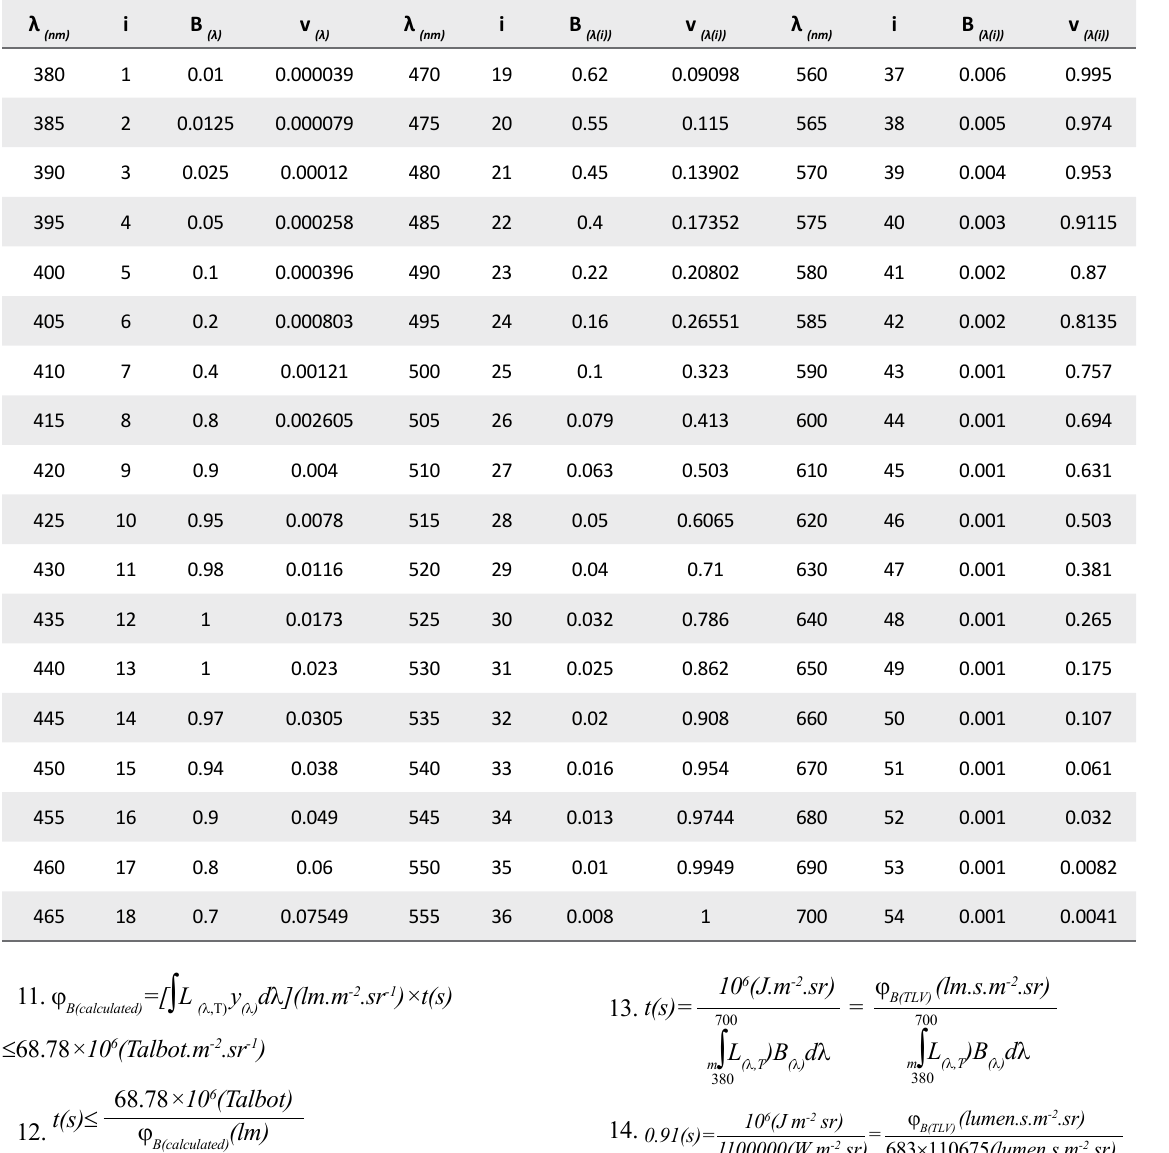
, and photopic sensitivity v (λ)